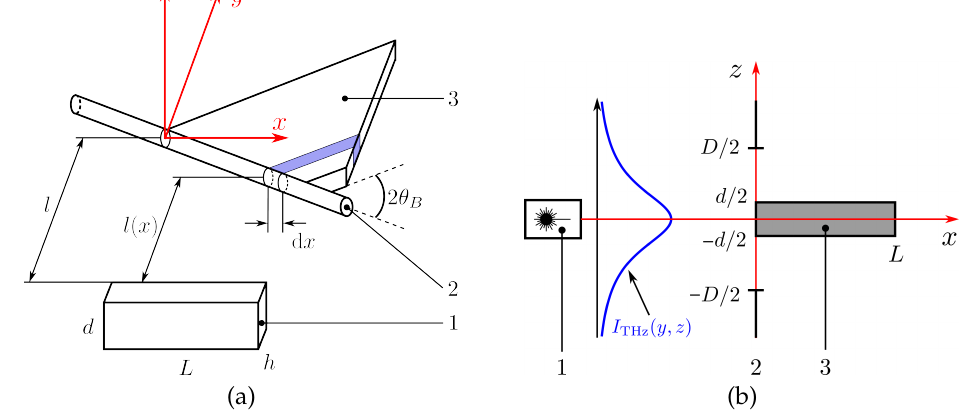
Figure 2. Schematic of AO interaction: ( a ) 1—ultrasound transducer, 2—transmitted radiation beam, 3—diffracted radiation beam; ( b ) 1—radiation source, 2—diaphragm, 3—region of AO